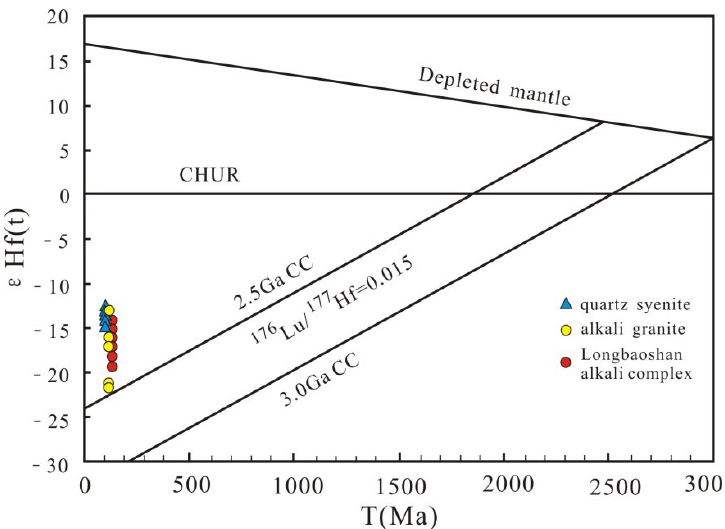
Figure 9. Zircon Hf isotope diagram of Chishan alkali complex. Other data sources: Longbaoshan alkaline complex [65].